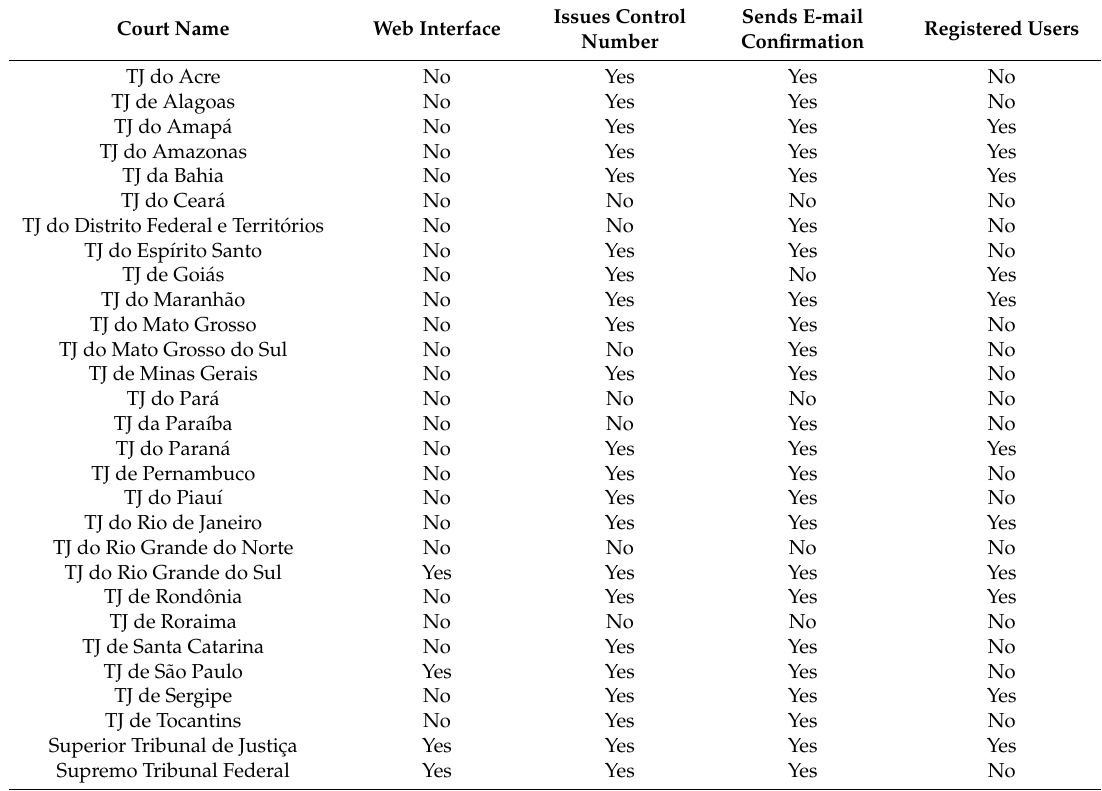
Table 1. Comparative analysis of information access